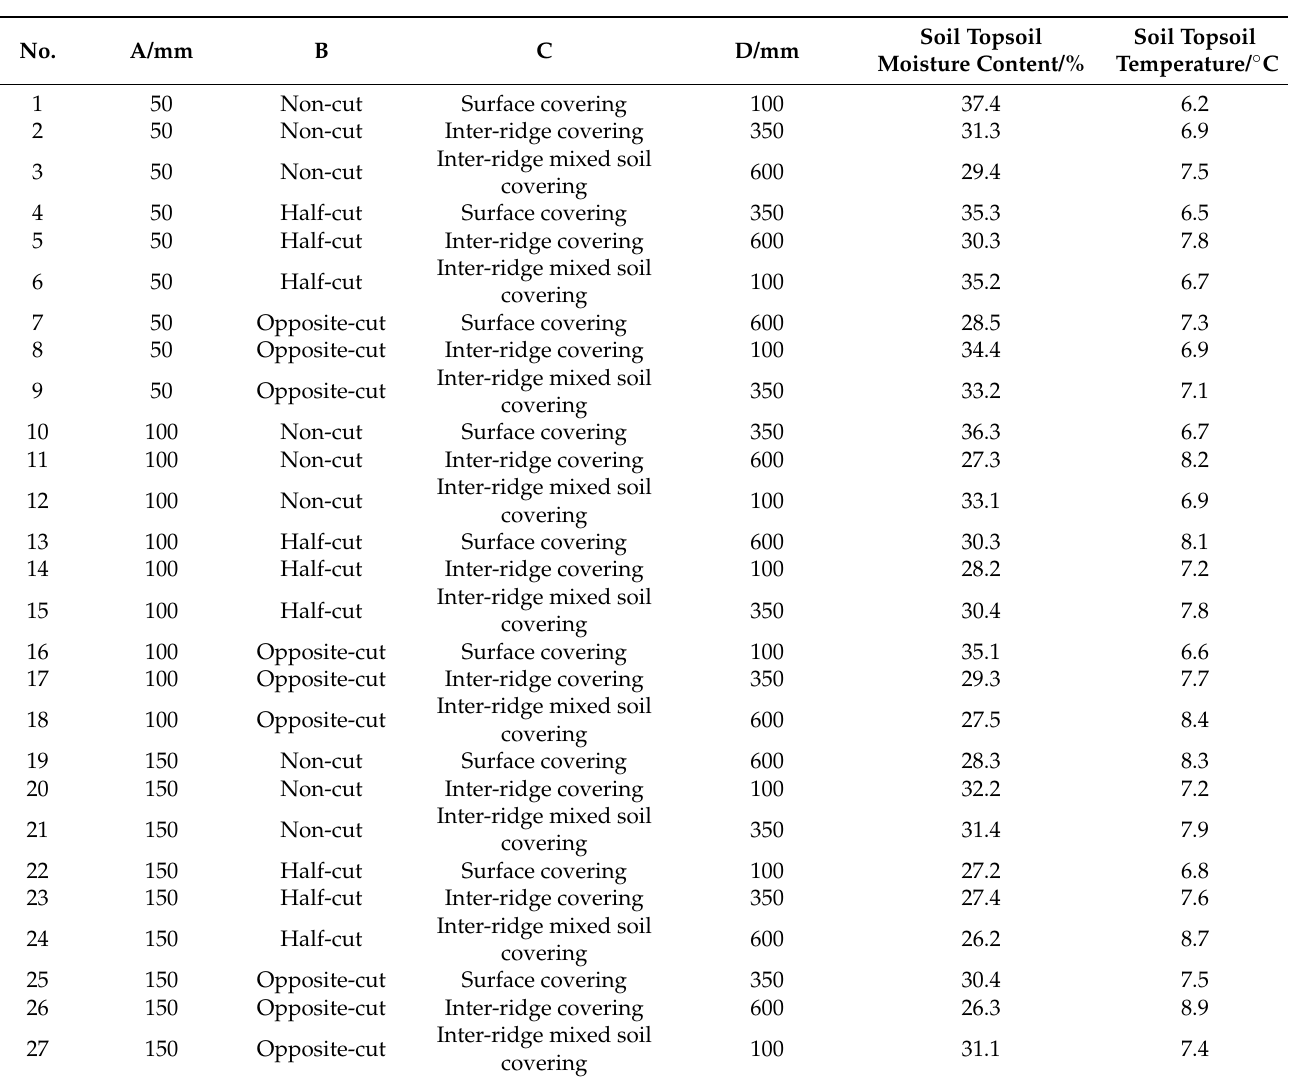
Table 2. Table of test scheme and results for the influence of corn straw morphological combinations on soil temperature and